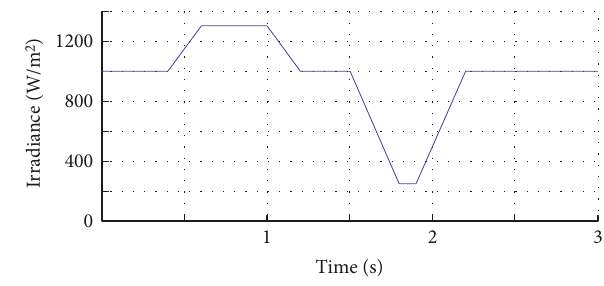
Figure 7: Sun irradiance.